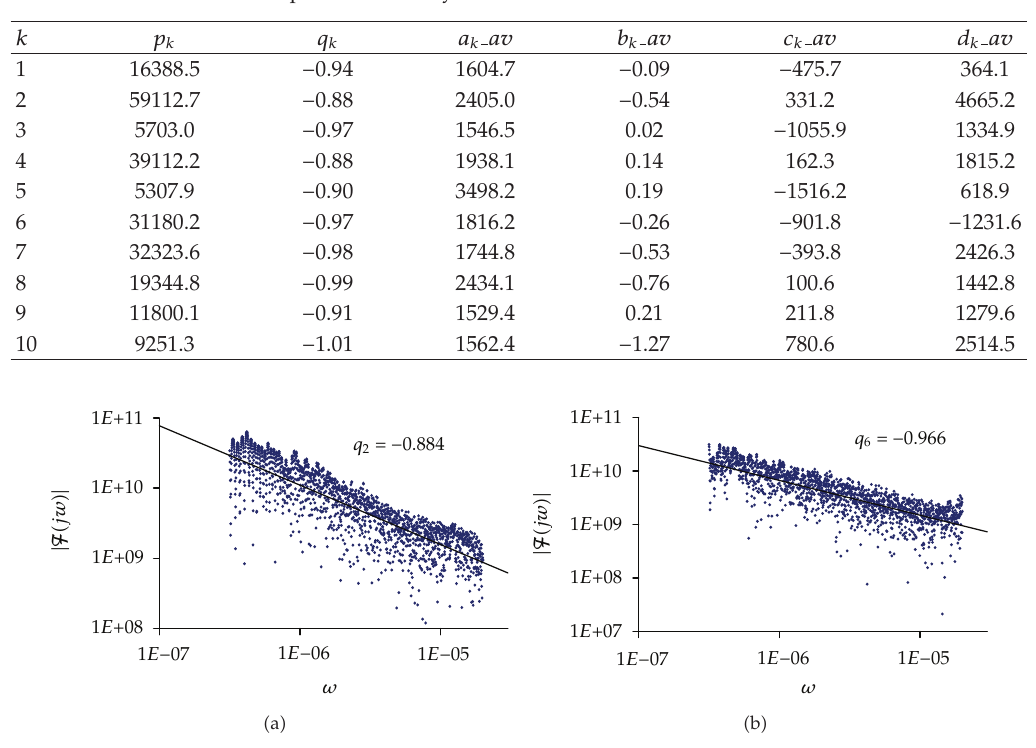
Table 3: Parameter values for the ω PL (cid:2) left (cid:3) and average parameter values for t PL, with ε (cid:8) 0 . 05 (cid:2) right (cid:3) for the ten stock markets adopted in the study.